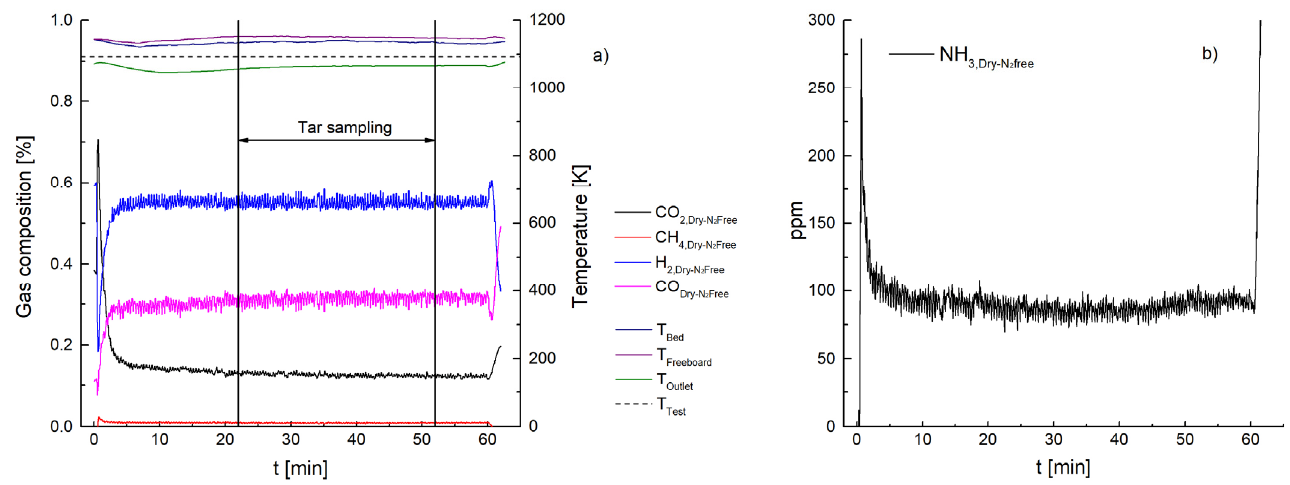
Figure A5. Temperature and gas composition ( a ) and ammonia content ( b ) during test 6.